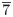
Distribution of the characteristic numbers Λ for all the analysable self-replicating chemical reaction systems up to where the possibly largest molecule is 7¯.The blue lines correspond to all integer self-replicating systems, while the red bars correspond to all other systems.